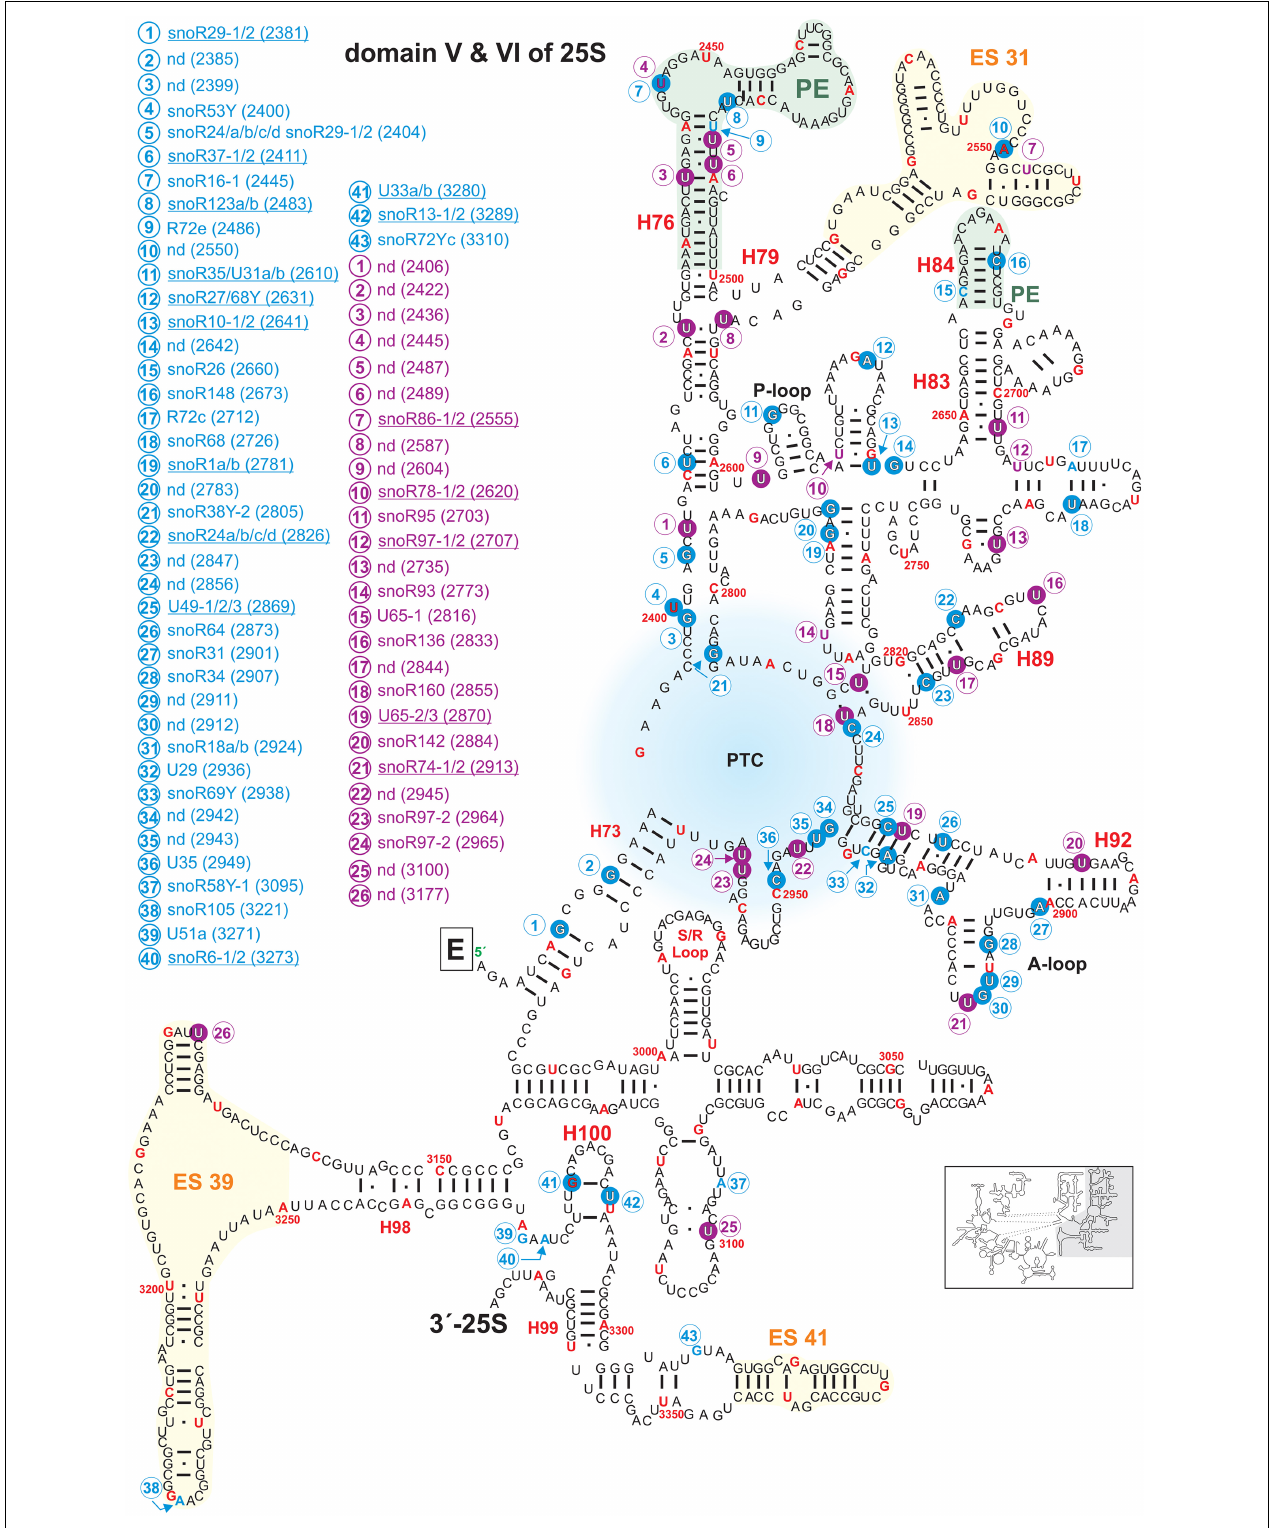
FIGURE 7 | Secondary structure diagram of domain V and VI of 25S rRNA of A. thaliana . The image is shown according to the legend for Figure 3 . Framed large letters indicate the position of the connections in subsequent images (for E see Figure 6 ). The region of the PTC is indicated in blue. The number in brackets correspond to the modified nucleotide position. A small illustration of the whole 60S rRNA secondary structure highlighting the according region is enclosed.